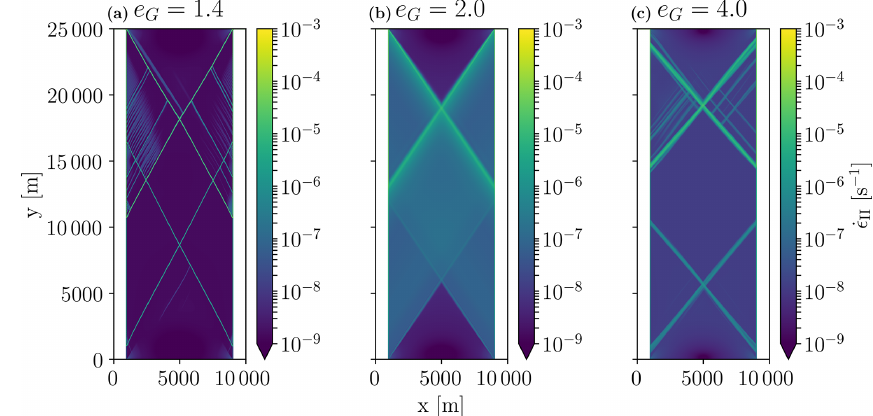
Figure 6. Diamond-shaped fracture pattern in the shear deformation field ˙ (cid:15) II for e F = 2 . 0 and three different values of e G after 5s of simulation. For the non-normal flow rule (a, c) , there are primary and secondary fracture lines, in contrast to the normal flow rule (b) where a single pair of fracture lines are simulated. The fracture angles are 29 . 92 ± 1 . 28 ◦ for e G = 1 . 4, 34 . 3 ± 0 . 25 ◦ for e G = 2 . 0, and 40 . 7 ± 0 . 94 ◦ for e G = 4 . 0. The error corresponds to 2 standard deviations (2 σ ) of the measured fracture